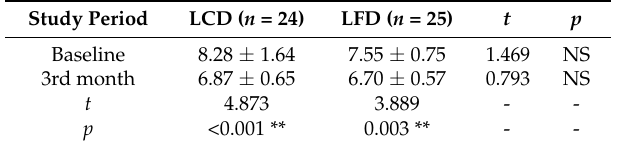
Table 6. Comparison of fasting blood glucose (mmol/L) between the two groups.